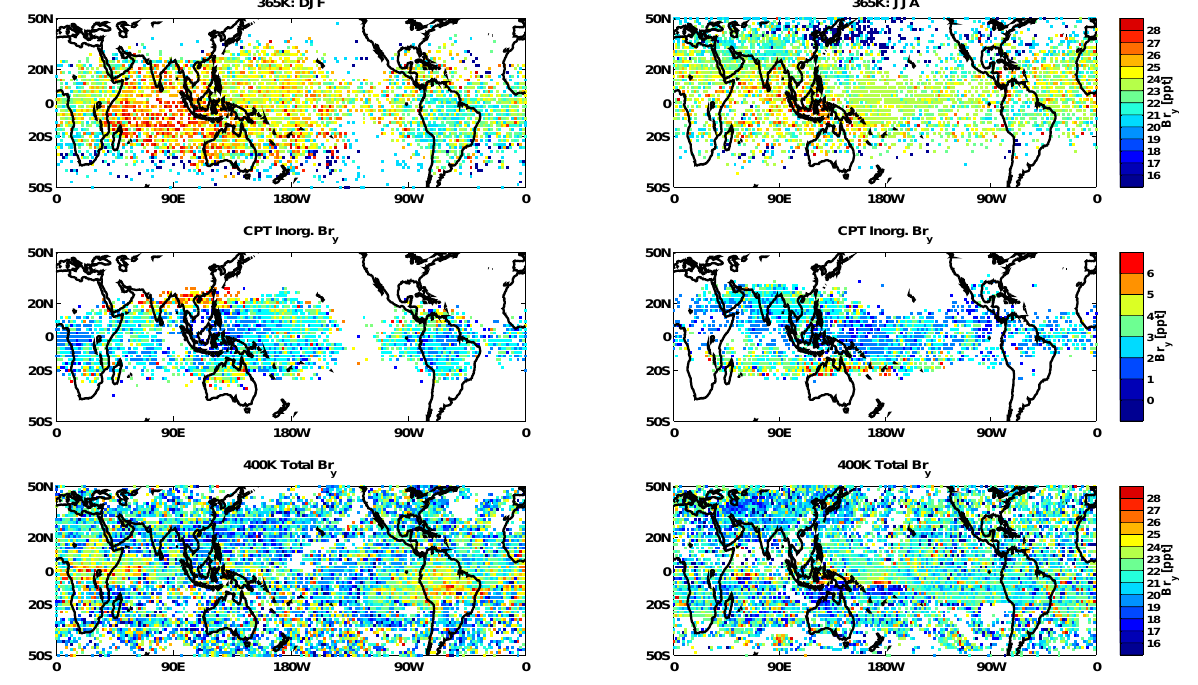
Fig. 7. Br y transport across the TTL for DJF and JJA. Top row provides the spatial distribution of total Br y (Br Inorg y +Br OrgSL y ) at 2 = 365K – i.e. the convective influence before this level. The second row displays inorganic Br y at the cold point available to washout. The third row gives the spatial distribution of total Br y at 2 =